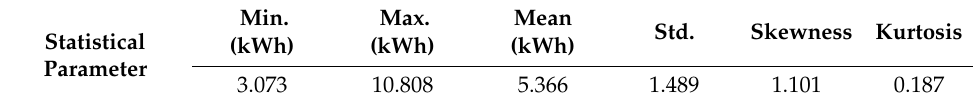
Figure 1. Energy consumption data from industrial buildings of the OPSD public dataset. Table 1. Descriptive statistics of energy consumption data.